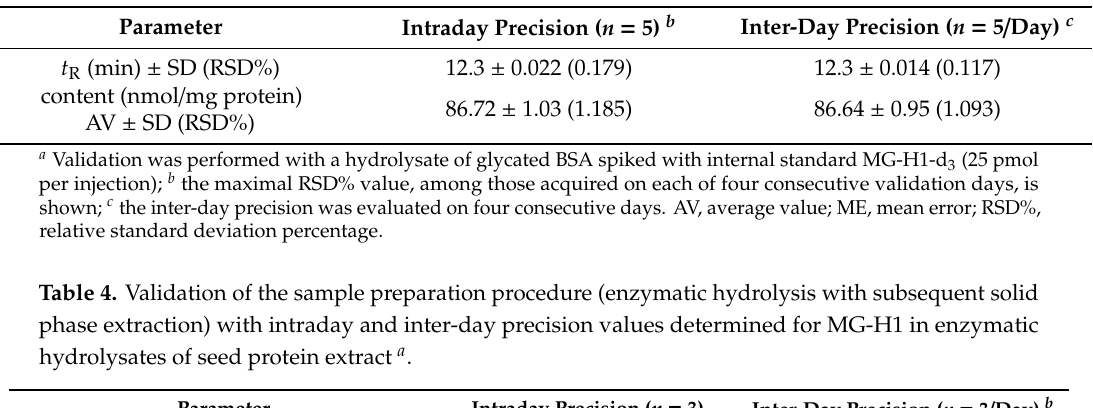
Table 3. Validation of RP-UHPLC-ESI-LIT-Orbitrap-MS quantification method with intraday and inter-day precision values determined for MG-H1 in enzymatic hydrolysates of glycated BSA a .